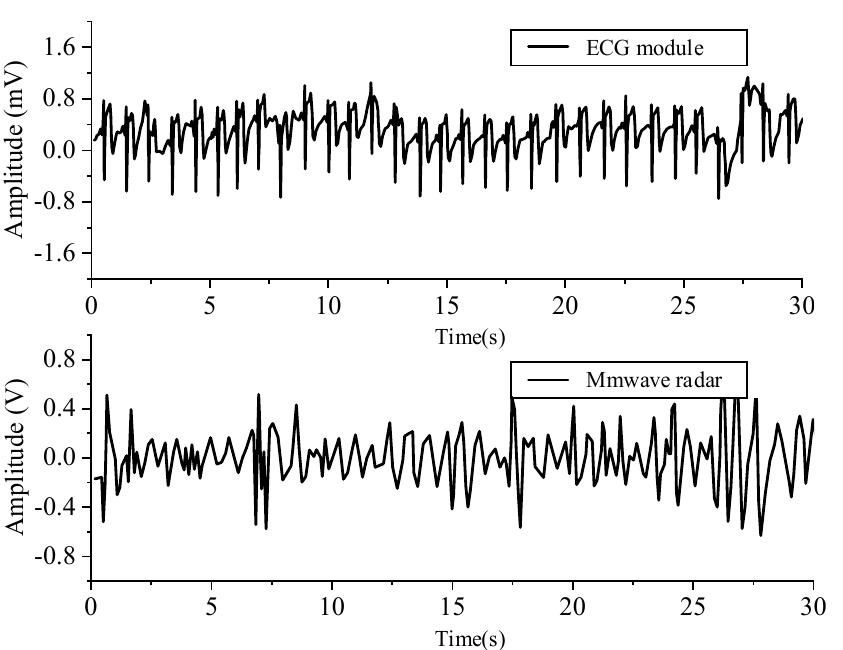
Figure 18. ECG and millimeter wave signals collected at the same time.